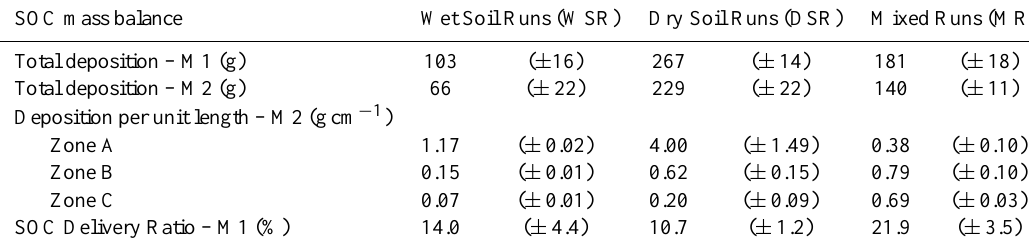
Table 2. SOC mass balance of the depositional area for the three simulation experiments. SOC mass